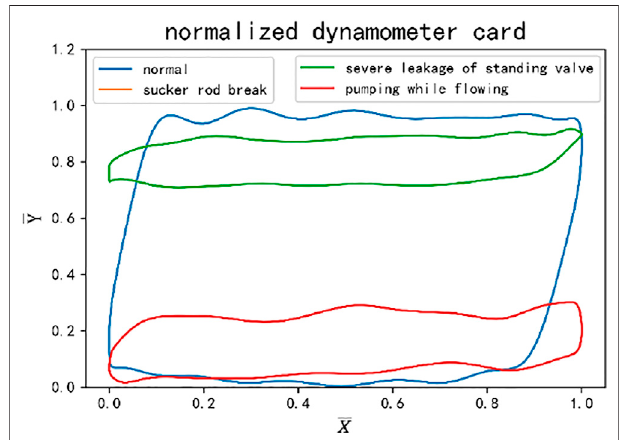
FIGURE 2 | Use of theoretical load normalization.